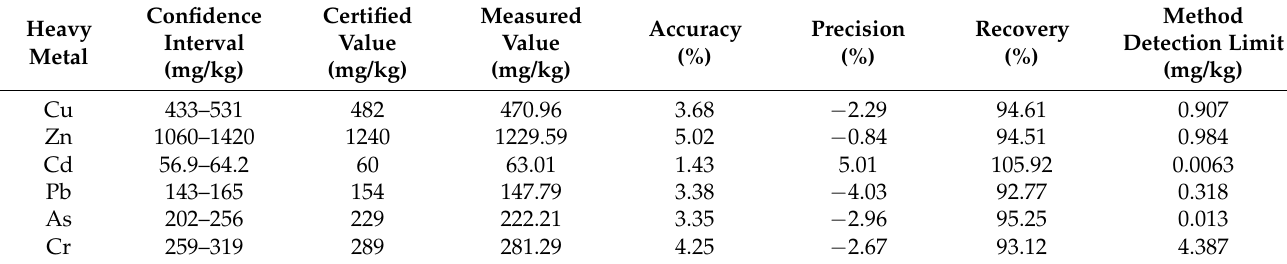
Table 1. Analytical accuracy, precision, recovery and method detection